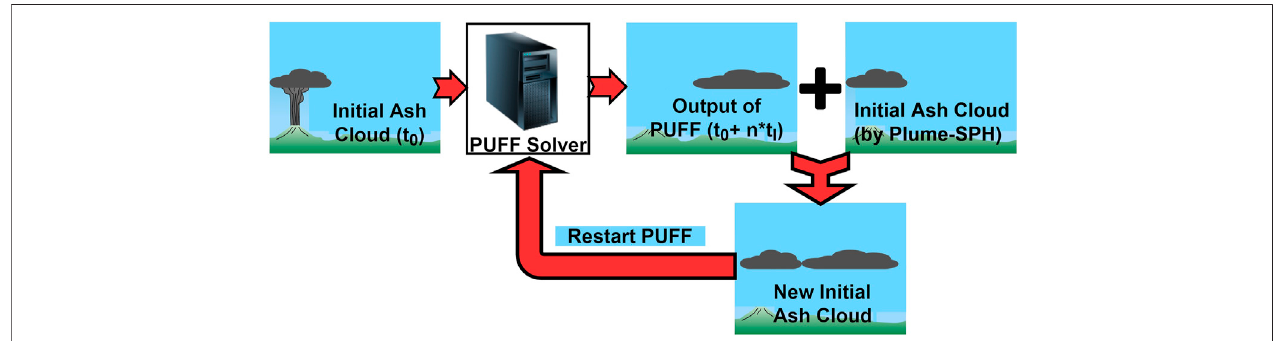
FIGURE 3 | Mimic successive eruption with intermittent pulsed releasing of ash particles. t I is the period of pulsing release. t I equals the physical time of 3D plume simulation.